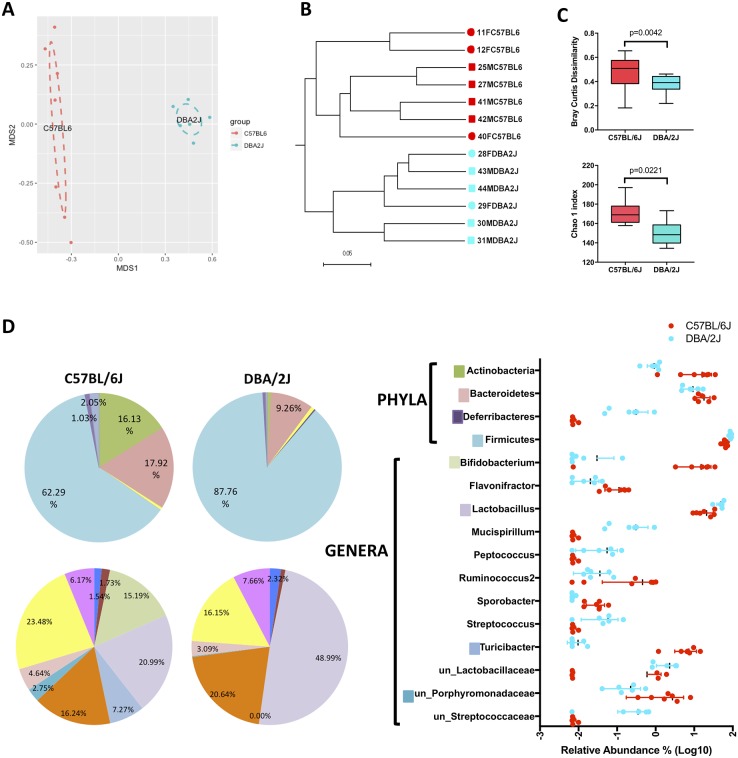
Gut microbiome composition of parental strains.Clustering of samples by NMDS of Bray Curtis dissimilarity (A) and dendrogram of Unweighted Unifrac distances (B) show that microbial communities of C57BL/6J mice are different from those of DBA/2J mice. Analysis of Bray Curtis dissimilarity (C-top) as a measure of β-diversity shows that DBA/2J mice have a lower degree of inter-individuality, while α-diversity analysis of Chao 1 index (C-bottom) shows that the gut microbiomes of C57BL/6J mice are richer and contain a higher number or rare species than those of DBA/2J mice. Pie charts and graph show relative abundance (D) of taxa present in both strains at the phylum, family and genus level. Taxa whose abundance was lower than 1% were grouped in the pie chart. Only statistically significant taxa are shown in graph on right. Statistics: Mann-Whitney t-test or Multiple t-test, lines and bars represent mean and standard deviation.